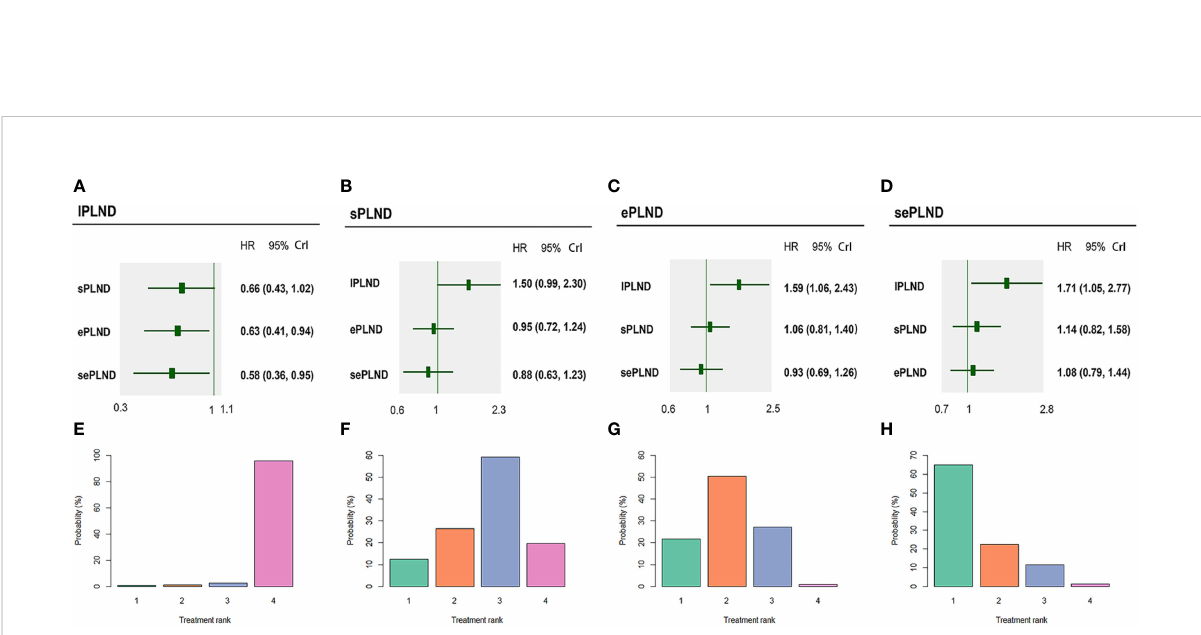
FIGURE 8 Bayesian network analysis results for OS and rank probabilities of each PLND template based on the random-effects model. (A) Other three PLND templates vs. lPLND template. (B) Other three PLND templates vs. sPLND template. (C) Other three PLND templates vs. ePLND template. (D) Other three PLND templates vs. sePLND template. (E) Probabilities of ranking the lPLND template in the fi rst, second, third and fourth place among four PLND templates. (F) Probabilities of ranking the sPLND template in the fi rst, second, third and fourth place among four PLND templates. (G) Probabilities of ranking the ePLND template in the fi rst, second, third and fourth place among four PLND templates. (H) Probabilities of ranking the sePLND template in the fi rst, second, third and fourth place among four PLND templates. OS, Overall survival. PLND, Pelvic lymph node dissection. HR, Hazard ratio. CrI, credible interval. lPLND, limited pelvic lymph node dissection. sPLND, standard pelvic lymph node dissection. ePLND, extended pelvic lymph node dissection. sePLND, super-extended pelvic lymph node dissection.